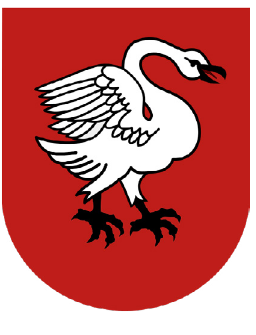
Figure 12. The former arms of Zbąszyń.